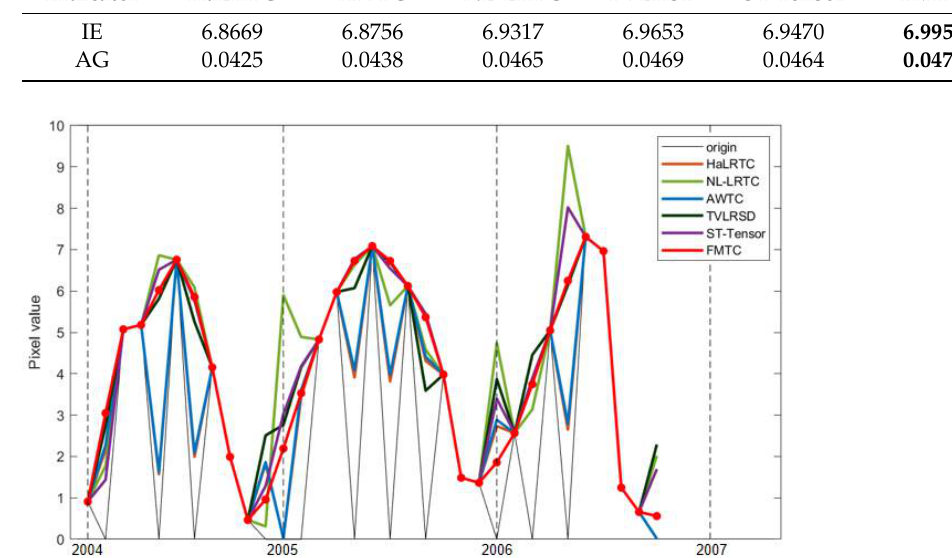
Figure 18. The time-series curves of six algorithms applied to one pixel from 2004 to 2006.